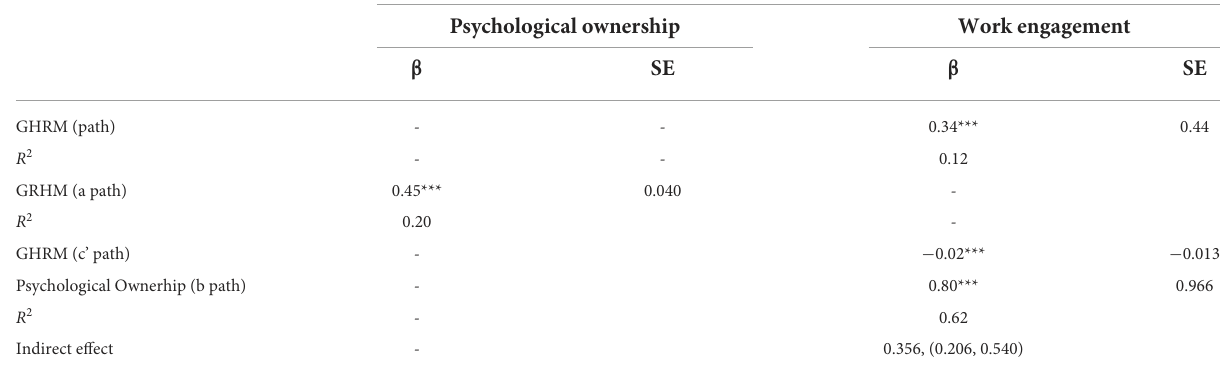
TABLE 4 The structural model and hypothesis testing.